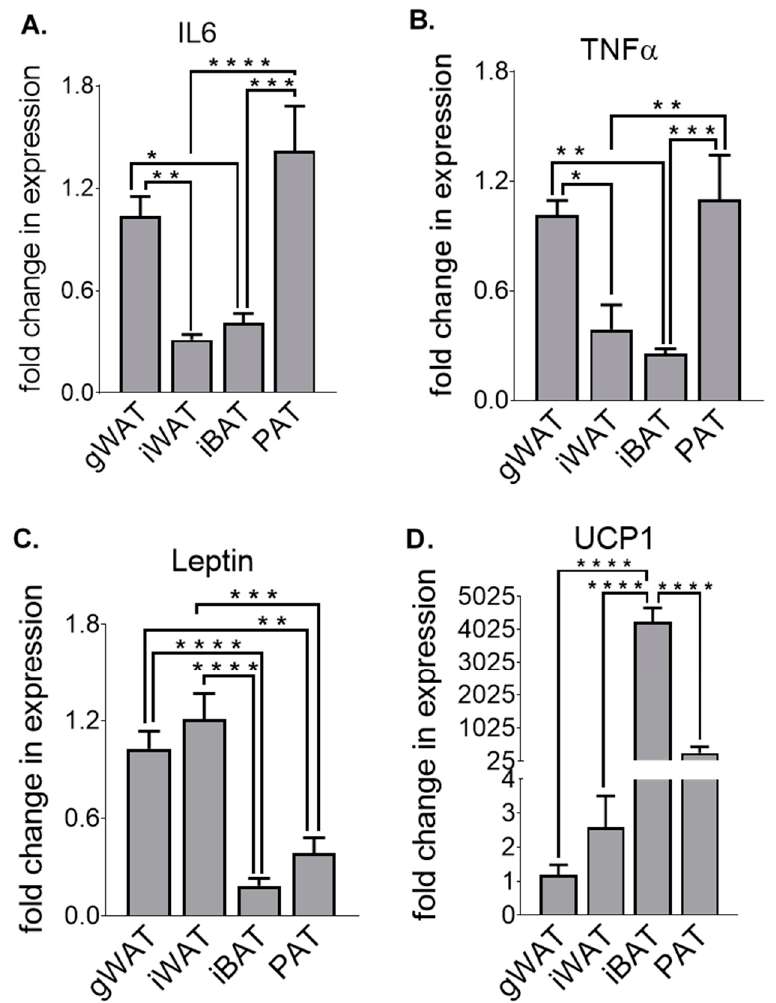
Figure 6. IL6 ( A ), TNF α ( B ), Leptin ( C ) and UCP1 ( D ) fold change in mRNA expression in gWAT, iWAT, iBAT and PAT of high-fat (HF)-fed 30-week-old male mice. All data are relative to the housekeeping gene PPIA and normalised to HF-gWAT. All data represent mean + s.e.m. Data were analysed by one-way ANOVA and Tukey’s multiple comparison test. N = 6–8. * p < 0.05, ** p < 0.01, *** p < 0.001 and **** p < 0.0001.